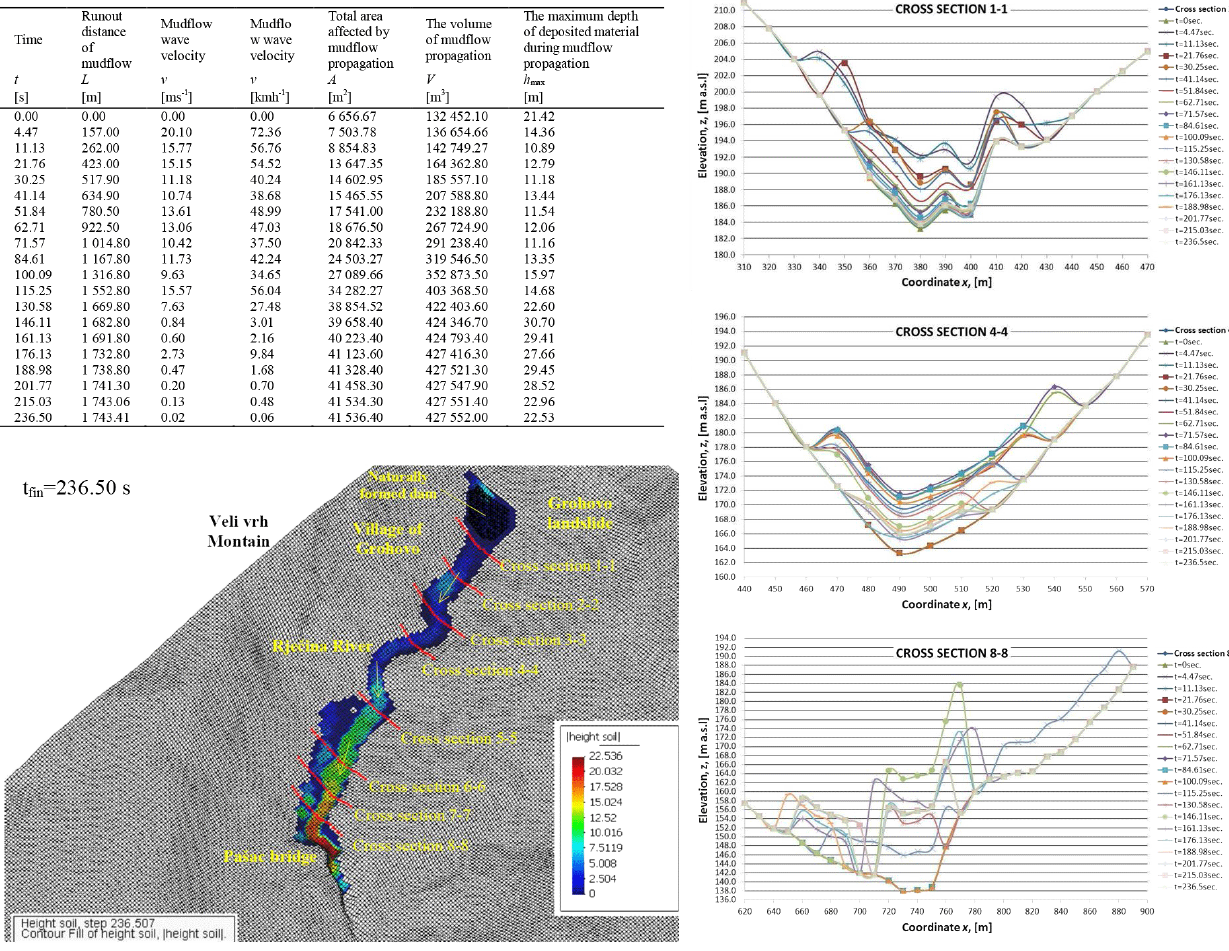
Figure 10. The results of the mudflow propagation on the Rjeˇcina River (based on the equidistant mesh grids of 5m × 5m), with the propagation of materials from a natural dam formed in the Grohovo landslide, Simulation